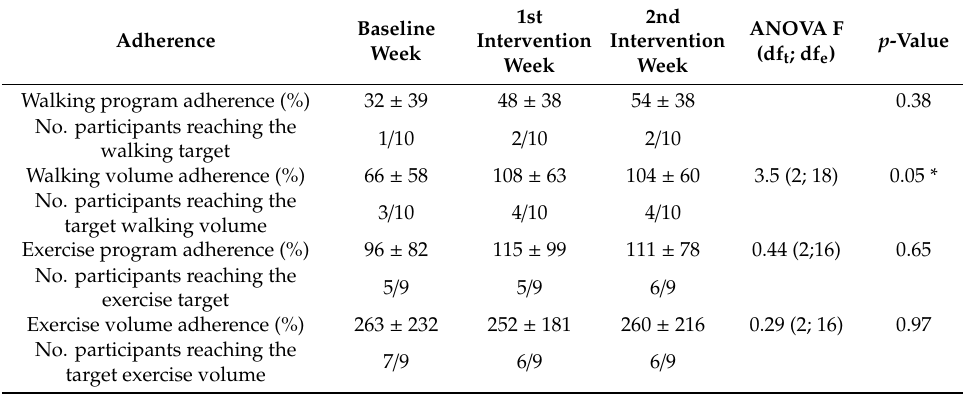
Table 3. Two weeks’ adherence to the walking and exercise